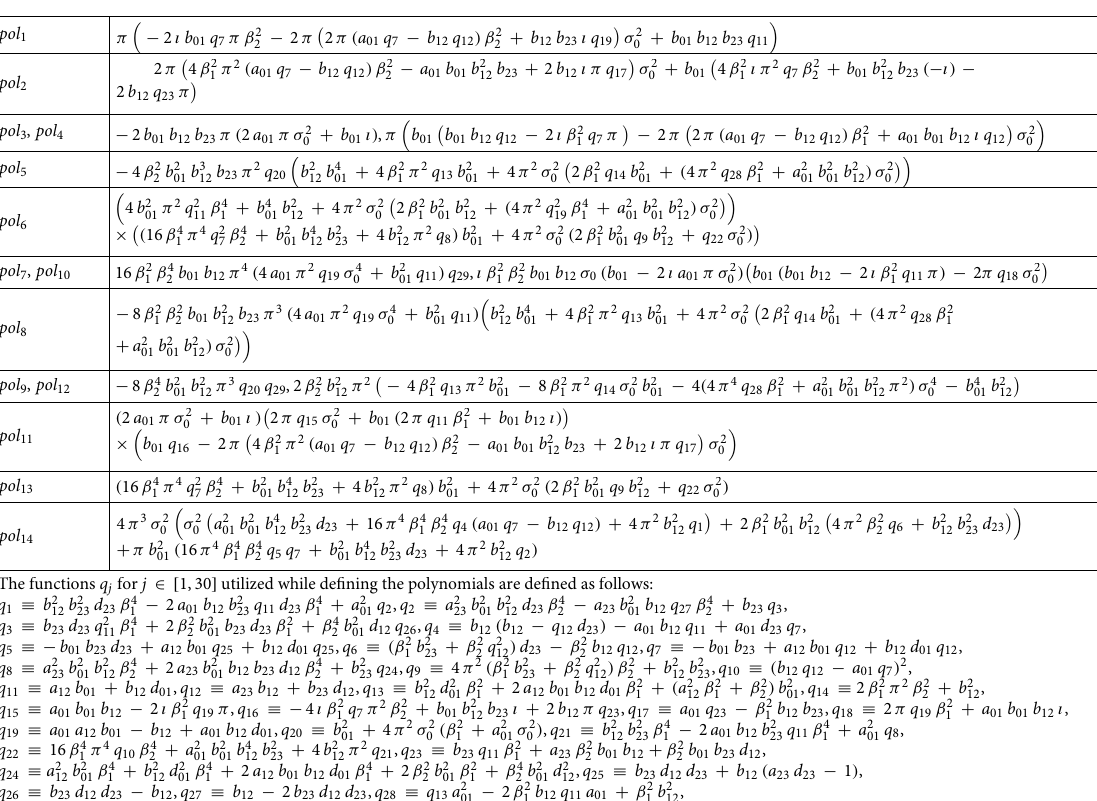
Table 2. Polynomial expressions in (18-21) for the case of N 0, 2 j ∈ [ ]